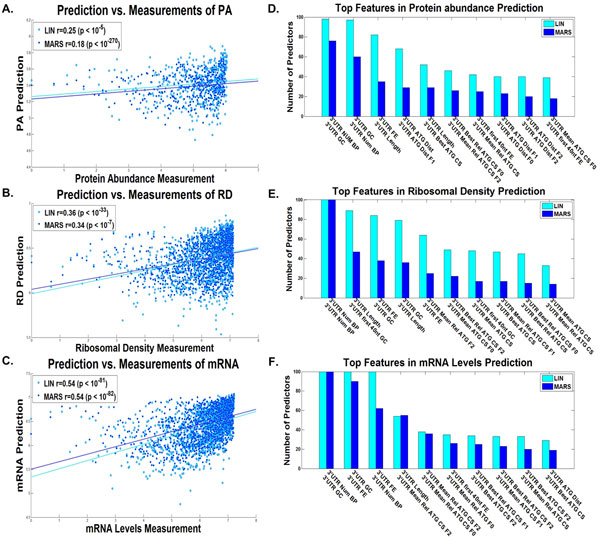
3'UTR linear and non-linear predictors results. Dot plot of the predictions vs. measurements for the validation set of the predictor with the median results for the A. protein levels, B. ribosomal densities, C. mRNA levels, for the 3'UTR linear (LIN) and non-linear (MARS) predictors (Additional file 1: Supplementary Methods). The best features according to the number of predictors they participated in (Additional file 1: Supplementary Methods) of the D. protein levels predictor, E. ribosomal density predictor, and F. mRNA levels predictor, for the 3'UTR linear (LIN) and non-linear (MARS) predictors (Additional file 1: Supplementary Methods).